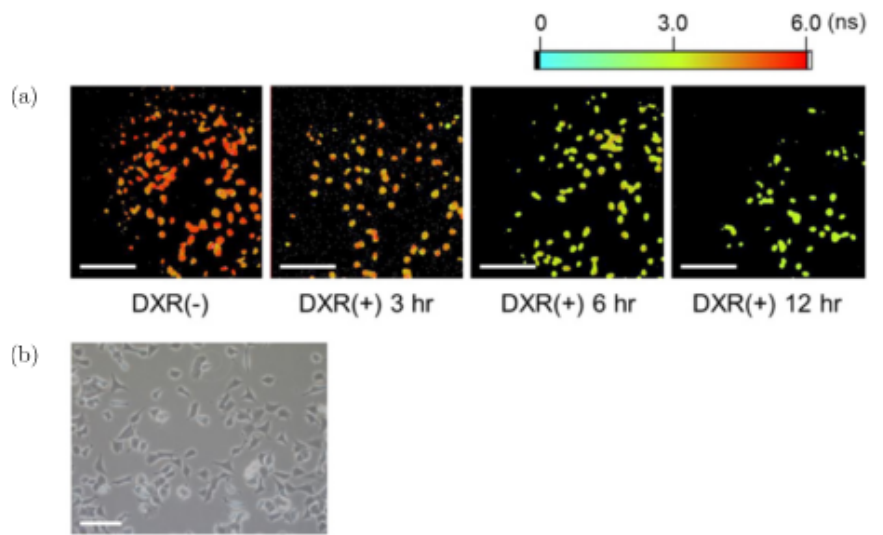
Fig. 15. (a) The FLIM images of the nucleus in RDES cells labeled with SYTO 13 before and after treatment with 500 nM of doxorubicin (DXR). (b) A phase-contrast image of RDES cells without treatment with DXR. Scale bar represents 100 (cid:1) m. 58 (Permission has been granted by \IOP Publishing" through Copyright Clearance Center's RightsLink r service.)